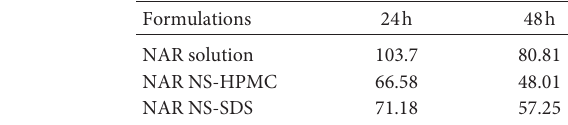
Figure 7: MTTassay showing effects of free naringenin and HPMC- and SDS-stabilized naringenin nanosuspensions on the cell viability of MCF-7 cells in a time- and dose-dependent manner. Data are expressed as the mean ± SD of three independent experiments ( n �